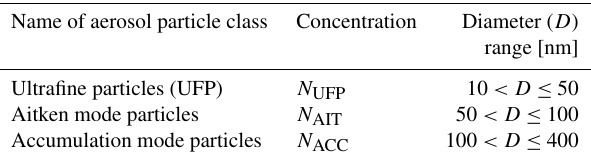
Table 1. Definitions, name abbreviations and symbols of the three aerosol particle size ranges used in this